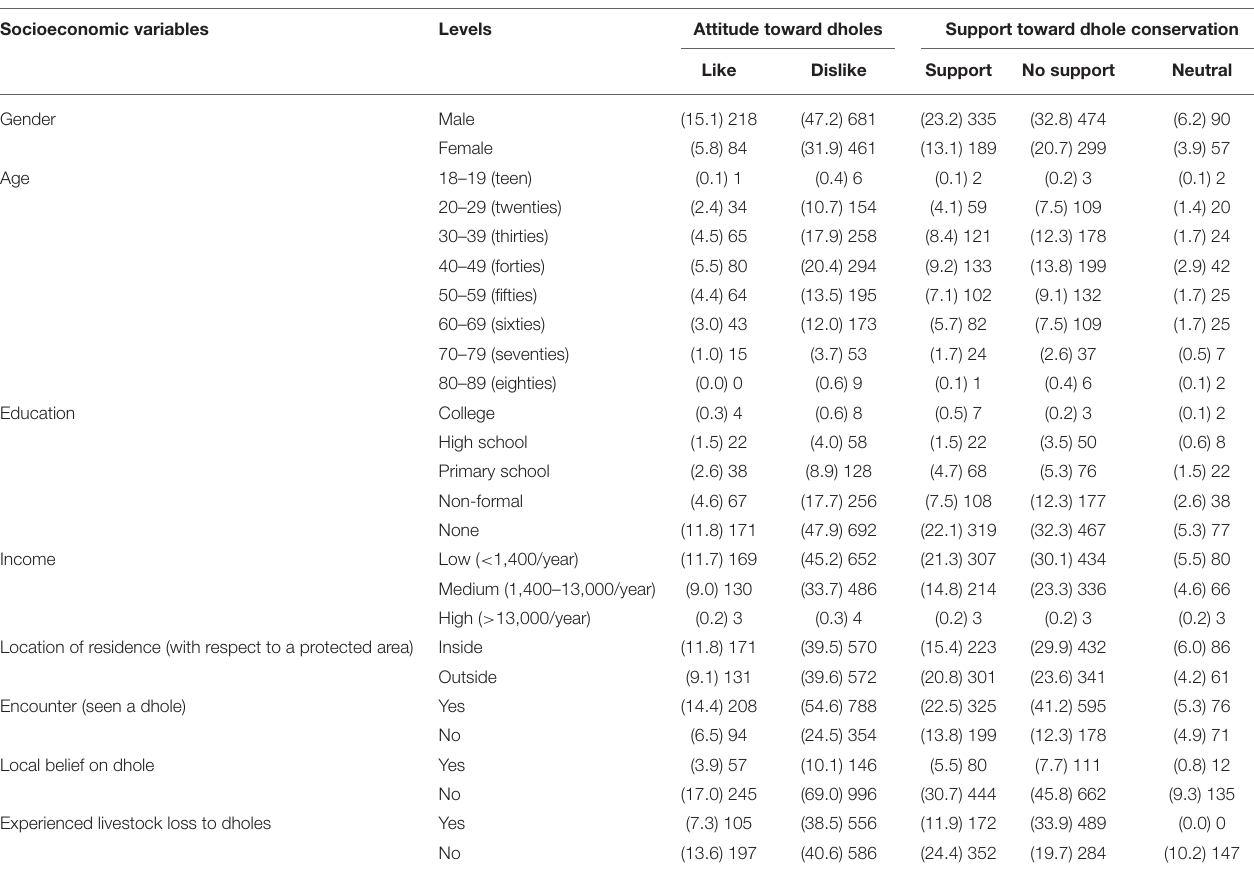
TABLE 1 | Socioeconomic variables of 1,444 respondents in rural Bhutan with respect to attitude and support toward the dhole ( Cuon alpinus ), based on a questionnaire survey from September to November 2019. Socioeconomic variables